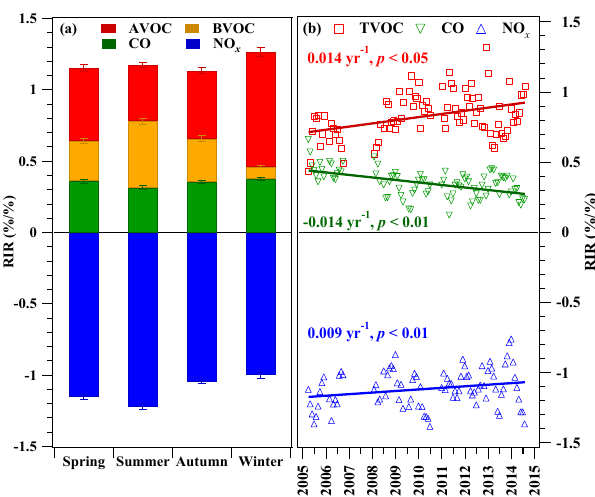
Figure 8. (a) Average RIR values of O 3 precursors in the four sea- sons and (b) trends of RIR values of O 3 precursors at TC from 2005 to 2014. AVOC represents anthropogenic VOCs, including 20 VOC species. BVOC means biogenic VOCs, including isoprene. Note: all the data are based on daytime hours (07:00–19:00LT).